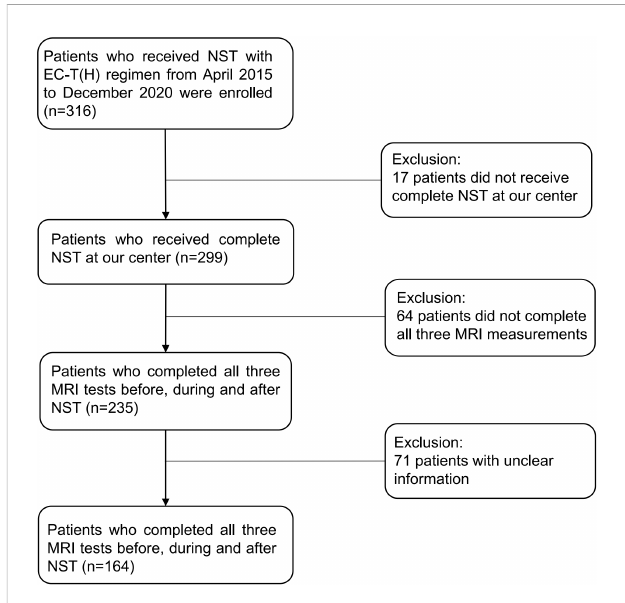
FIGURE 1 Flow chart of the study design. NST, neoadjuvant systemic treatment; EC-T(H), epirubicin and cyclophosphamide followed by paclitaxel with trastuzumab if